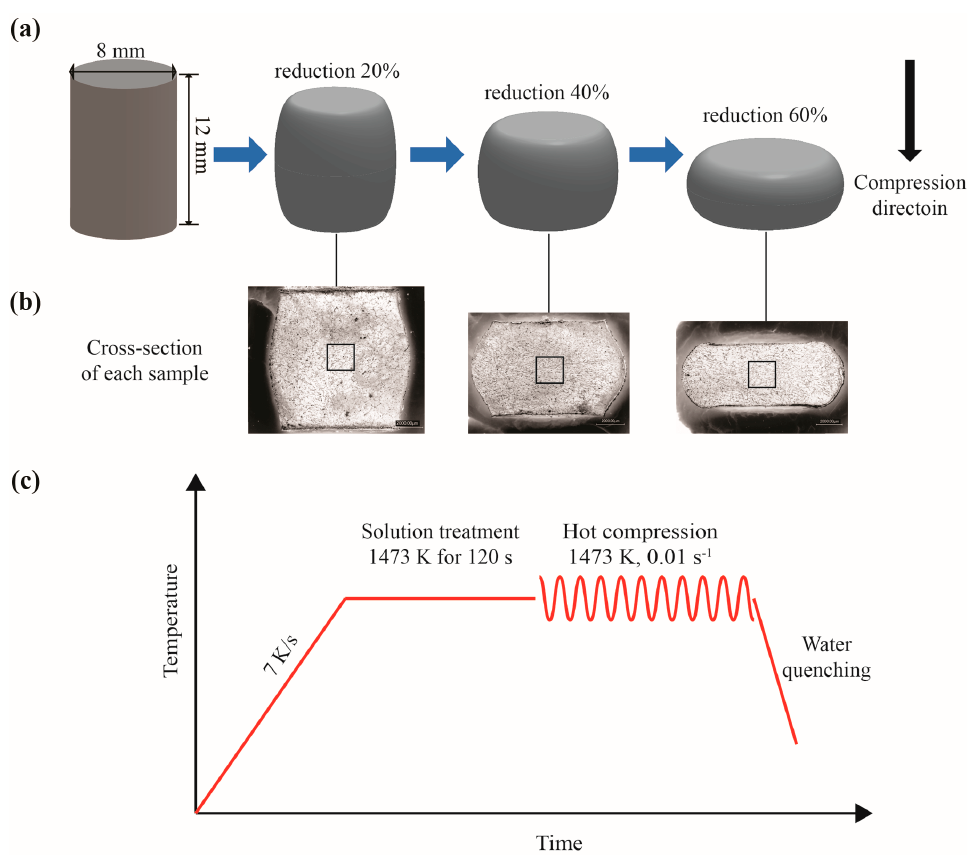
Figure 1. ( a )Processing parameters of thermomechanical treatment; ( b ) diagram of samples after thermomechanical treatment. The black arrow shows the compressive direction; ( c ) metallograph of each sample. The black rectangle marks the microstructure observation position.